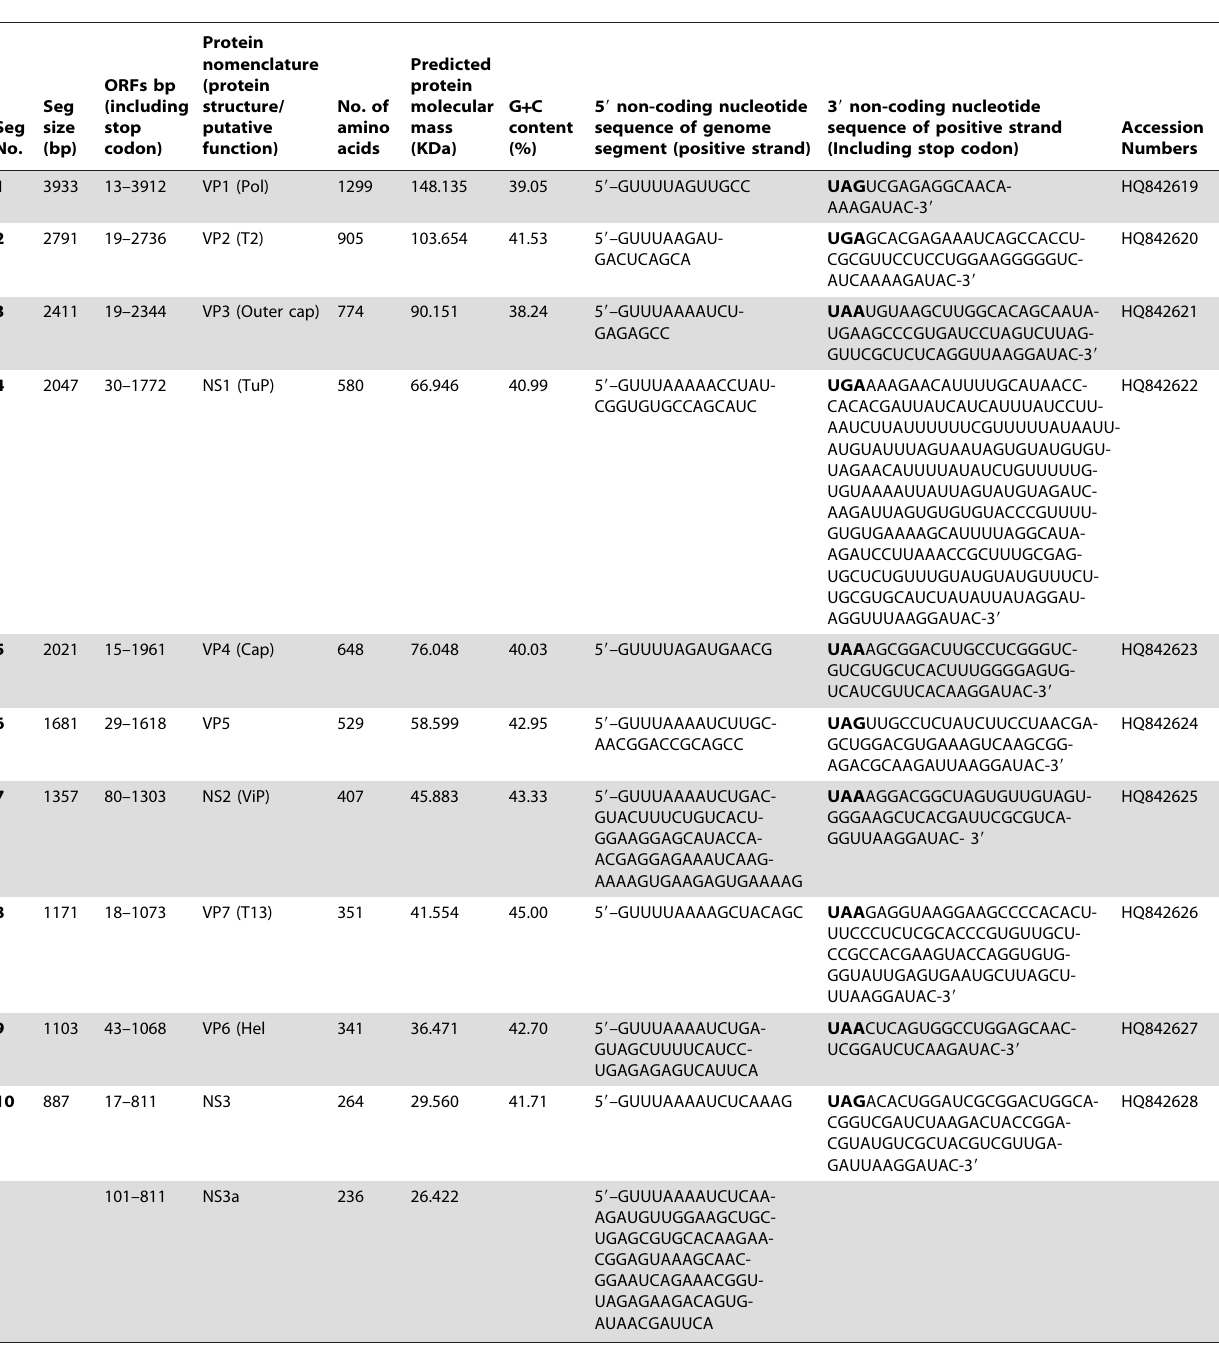
Pol=RNA polymerase; Outer cap= outer capsid protein; Cap=capping enzyme (guanylyltransferase); Hel=helicase enzyme; T2=protein with T=2 symmetry; T13=Protein with T=13 symmetry; ViP=viral inclusion body matrix protein; TuP=tubule protein. Letters in bold are the stop codon.